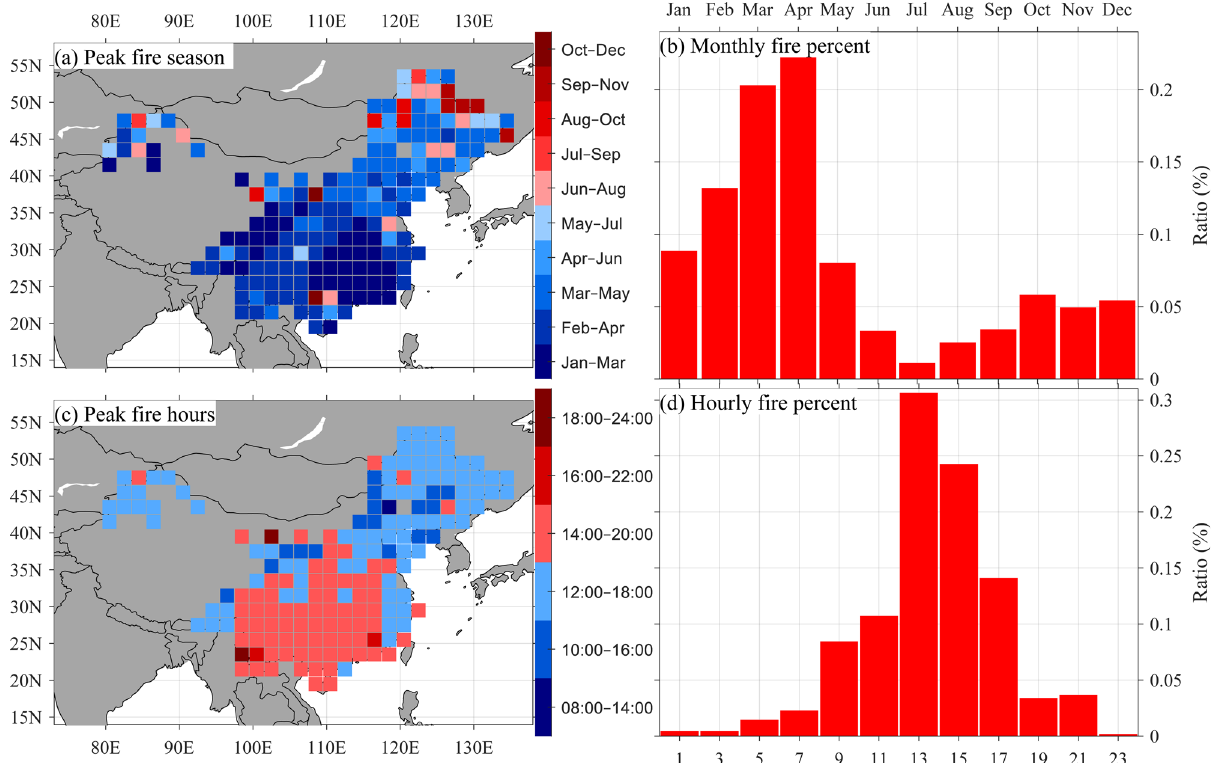
Fig. 2 Intra-annual and diurnal fi re occurrences of the Wild fi re Atlas of China (WFAC). a The peak fi re season for each gridpoint containing more than 50% (mean of 73%) of the fi re occurrences, b the monthly ratio (percentage of total fi re occurrences in a given month) of the WFAC fi re chronology, c the peak fi re hours for each gridpoint containing more than 50% (mean of 77.4%) of the fi re occurrences, and d the two-hourly ratio (percentage of total fi re occurrences in a given 2-h time period) of the WFAC fi re